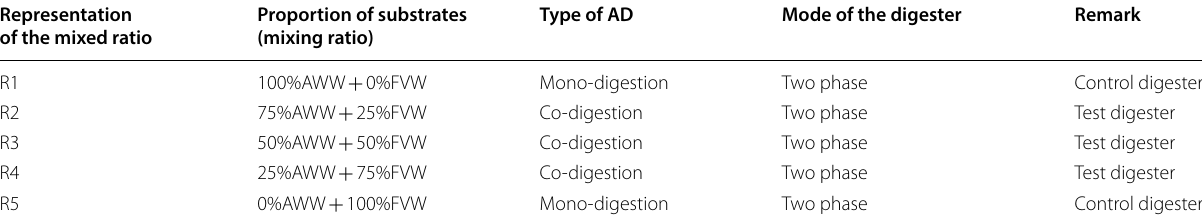
Type of AD Mode of the digester